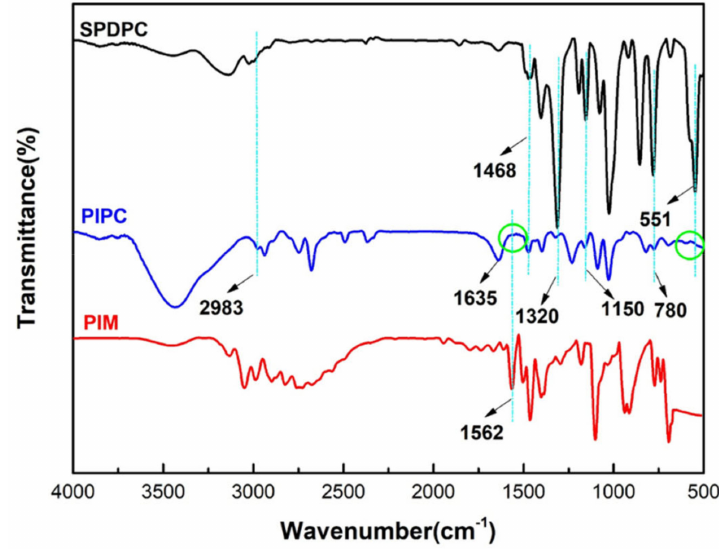
Figure 1. Fourier-transform infrared (FTIR)